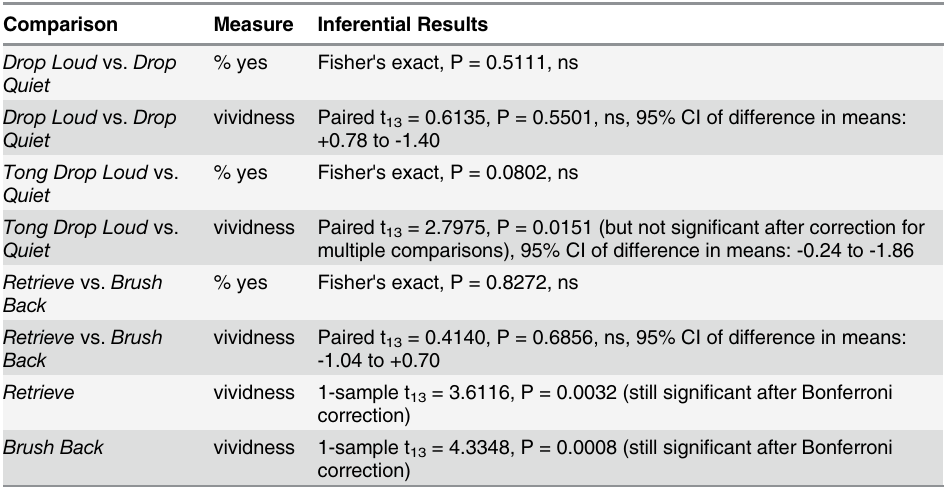
Table 2. Inferential